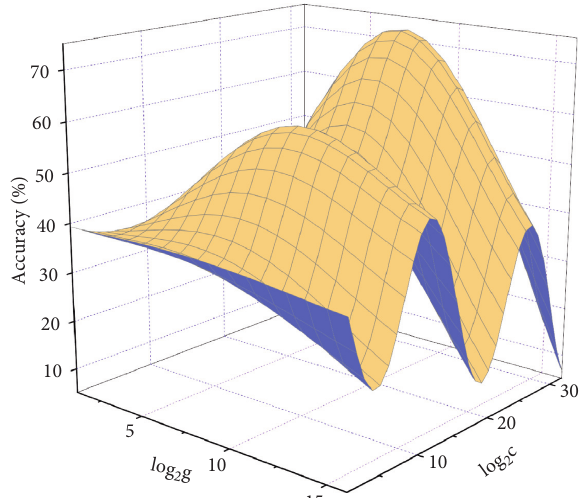
Figure 9: The change chart of the accuracy of cross validation in advance warning.